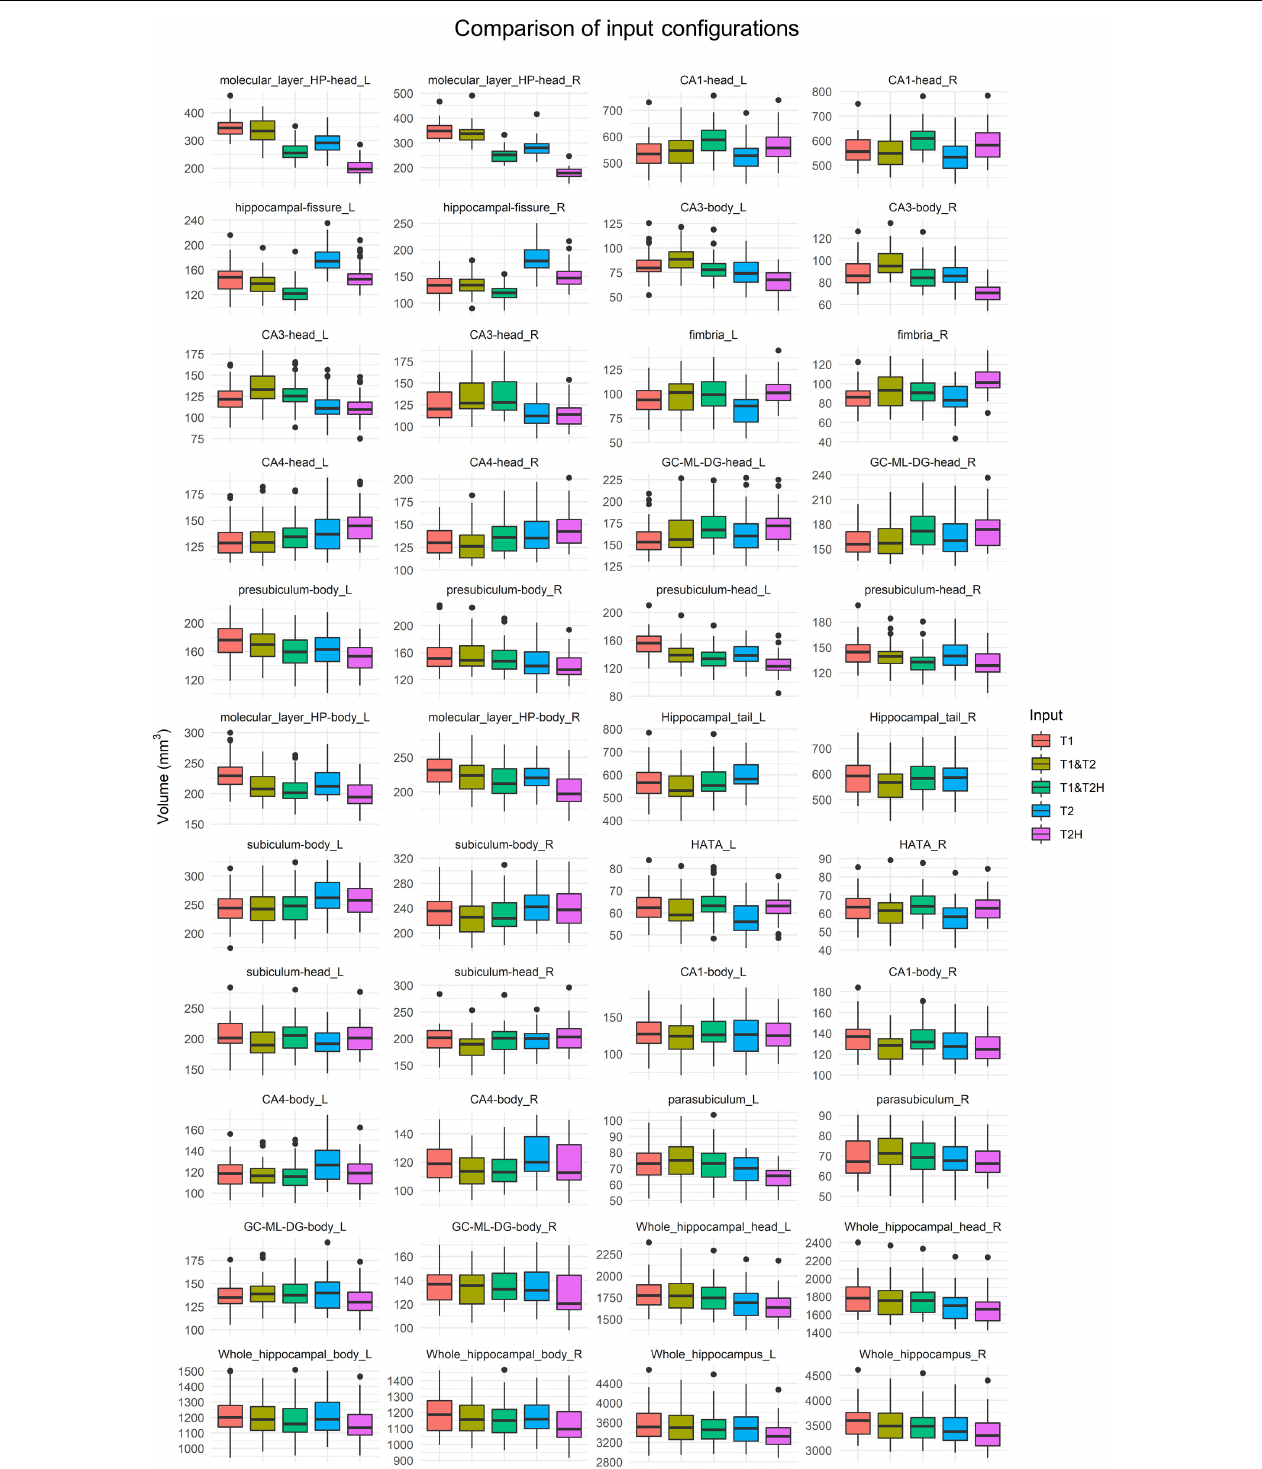
FIGURE 2 | Boxplots showing volume estimations of the cross-sectional hippocampal subfield investigation using five different input configurations (T1, T1 and T2, T1 and T2H, T2, and T2H). Subfields are arranged according to the height of effect sizes of the Friedman test (X 2 ) using Kendall’s W. In addition to the 19 ROIs, whole hippocampal head and body as well as whole hippocampal volume are presented. All subfields showed significant differences according to the Friedman tests (see Table 1 ). T2H was excluded for the hippocampal tail, as not the entire structure was covered due to the limited size of the field of view. T2, T2-weighted standard resolution; T2H, T2-weighted high resolution; GC-ML-DG, granule cell and molecular layer of the dentate gyrus; HATA, hippocampus-amygdala-transition-area.